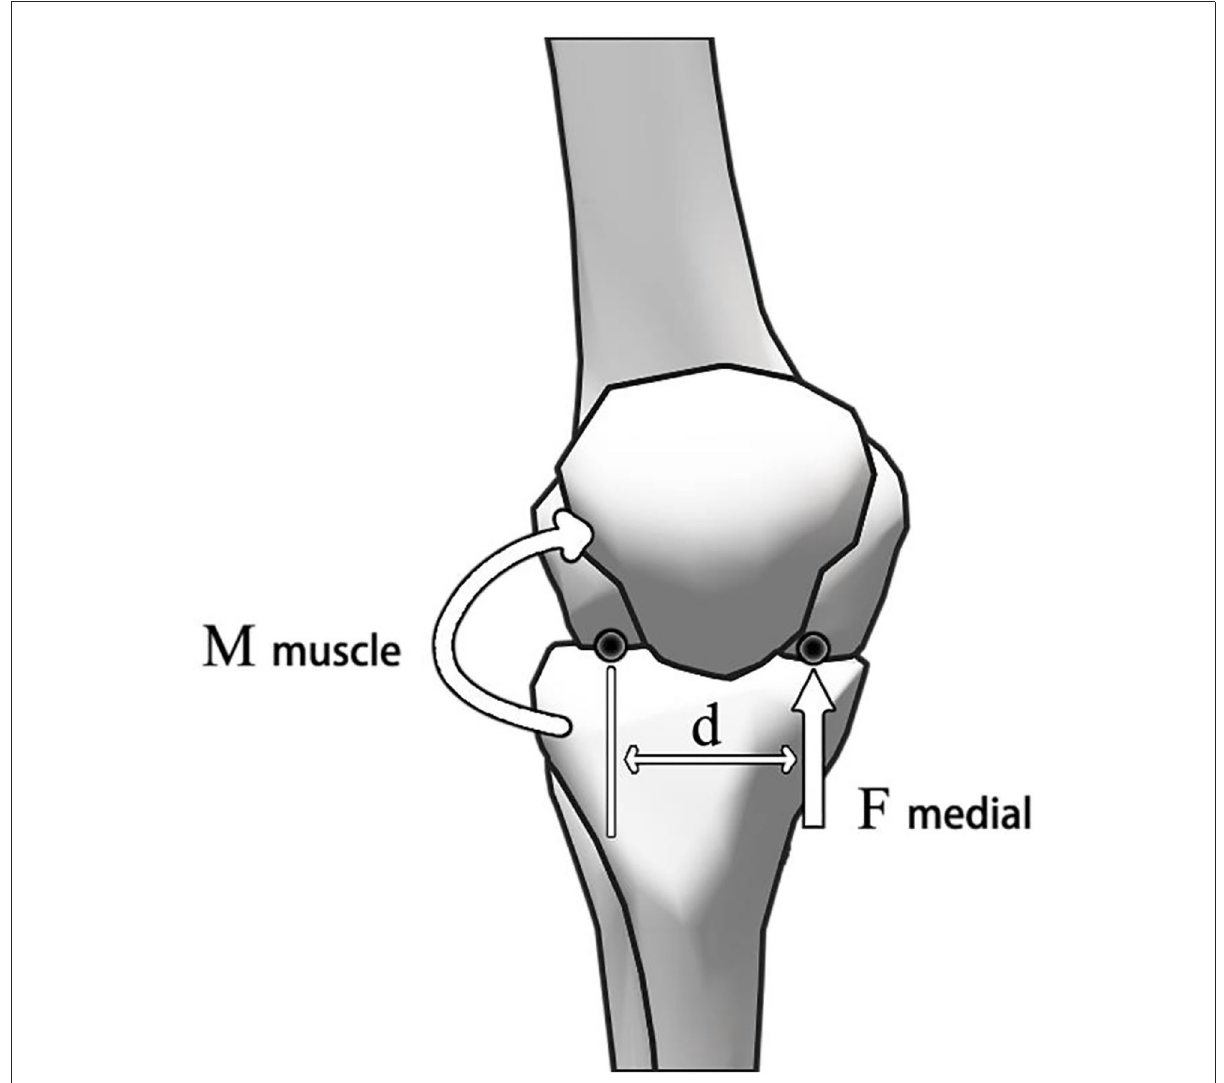
FIGURE2 Calculation of medial contact force of knee joint.